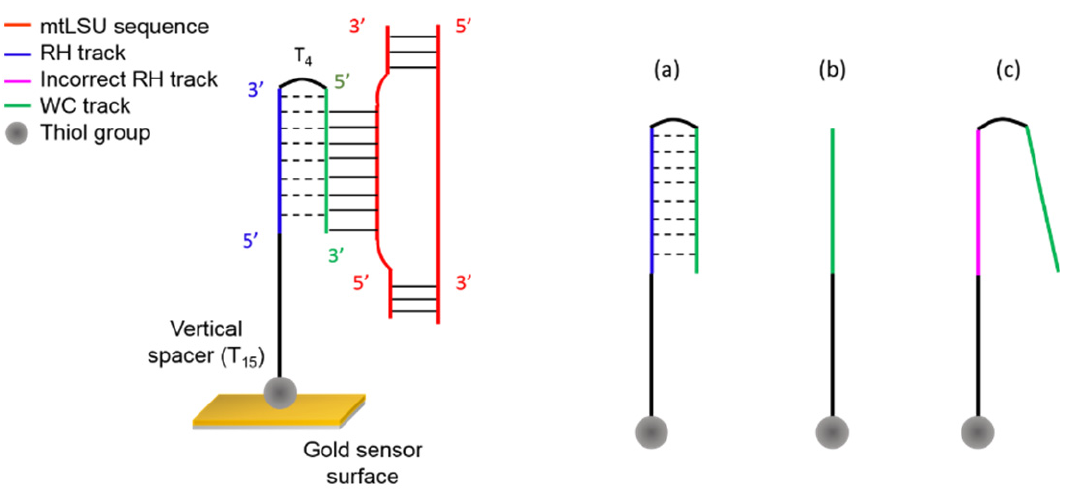
Figure 3. Schematic representation of the mtLSU rRNA gene capture using the PPRH probe, forming an antiparallel triplex structure. In addition, different bioreceptors employed in the SPR biosensor are shown: ( a ) PPRH probe, ( b ) complementary probe, ( c ) control PPRH probe. (Colors correspond to Figure 2).